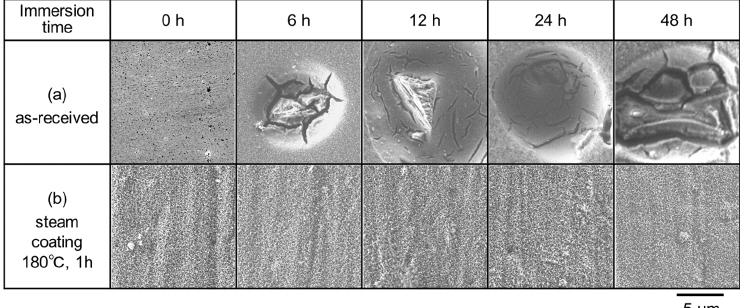
Figure 8. Low-magnification SEM images showing surface morphology of ( a ) uncoated specimen and ( b ) specimen subjected to steam coating at 180 °C for 1 h, after saltwater immersion for up to 48 h.